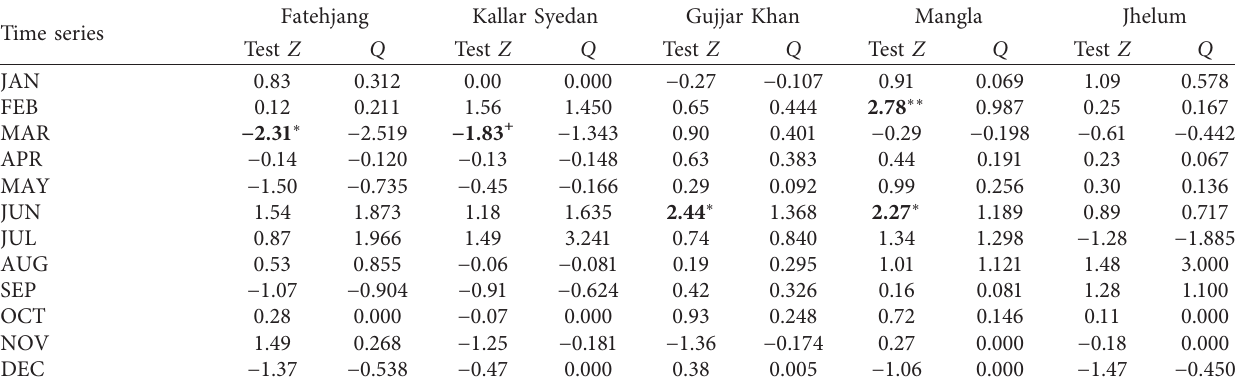
Table 4: Monthly, seasonal, and annual rainfall statistic in zone-2 stations using Mann–Kendall test and Sen’s slope estimate. Time